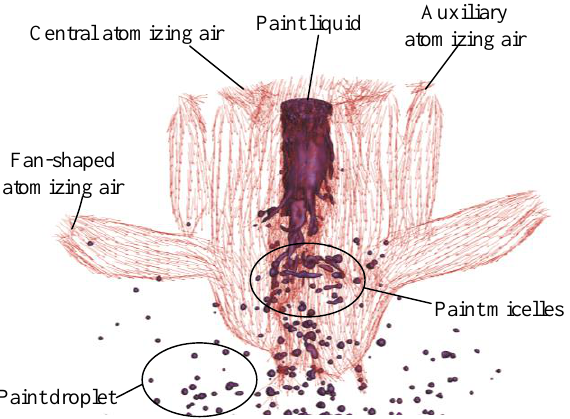
Figure 12. Paint atomization process.